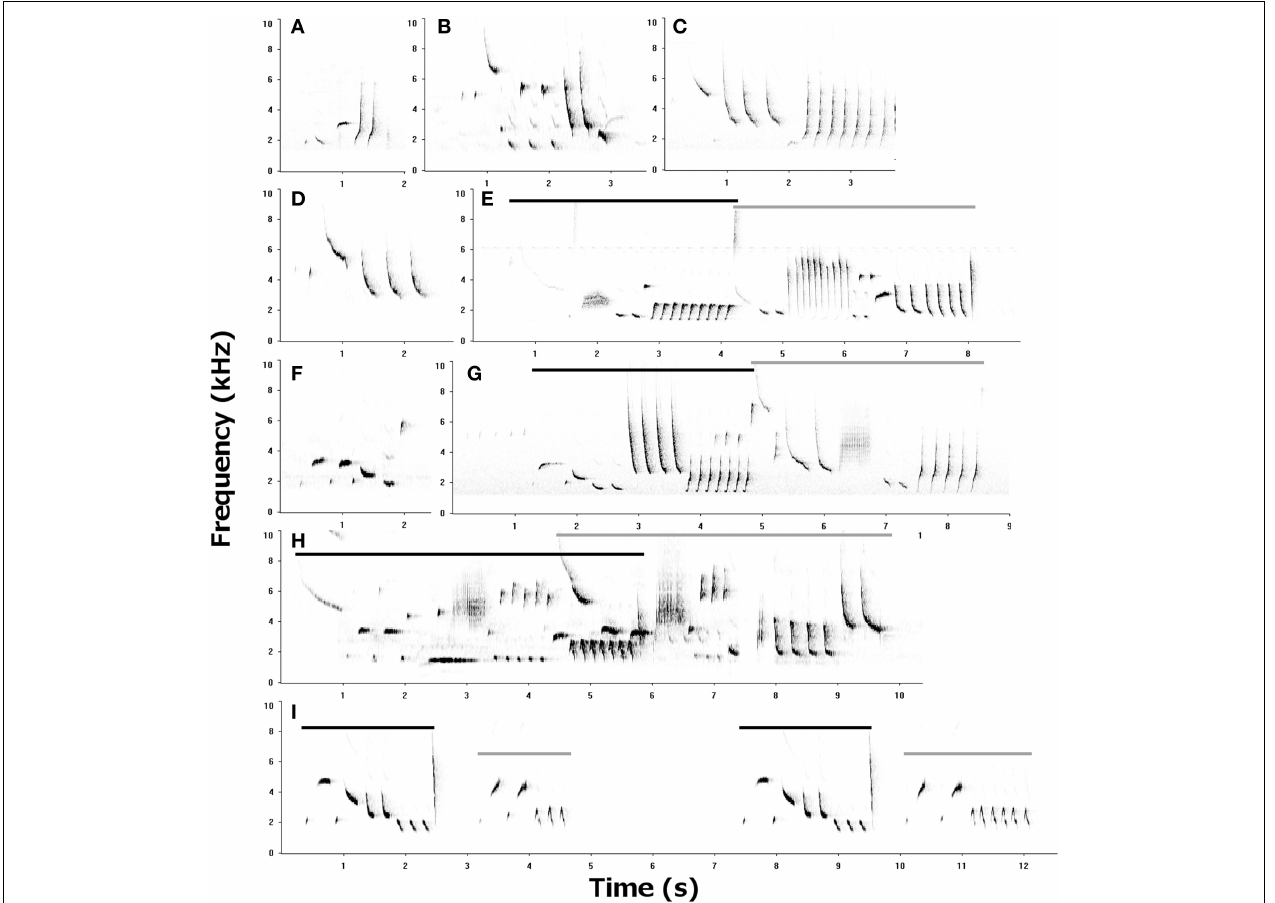
FIGURE 1 | Sonagrams of female songs (A–D, F) and male-female duets (E, G–I). Female song types are often similar to male song types, but more fragmentary. Songs given as answers to a partner’s song vary from overlapping (as in H ) to closely following (as in I ). Light bars are used to identify female songs in duets, and dark bars identify male songs. Examples illustrate similarities between